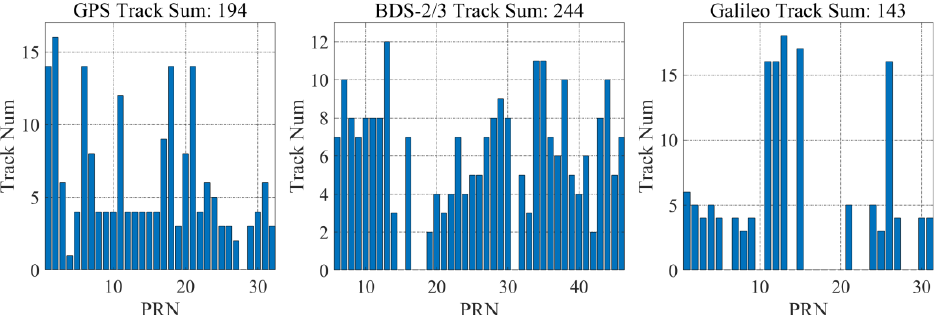
Figure 10. The number of tracks for each GNSS satellites from GPS (left), BDS-2/3 (middle), and Galileo (right) in one day (17 July 2022)